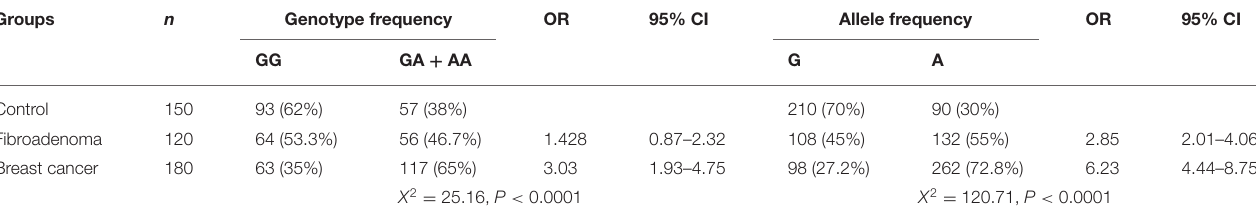
TABLE 2 | Differences in allele distribution and genotype frequency of MEG3 gene single nucleotide polymorphism (SNP) rs7158663 G/A between control, fibroadenoma, and Breast cancer groups. Groups n Genotype frequency